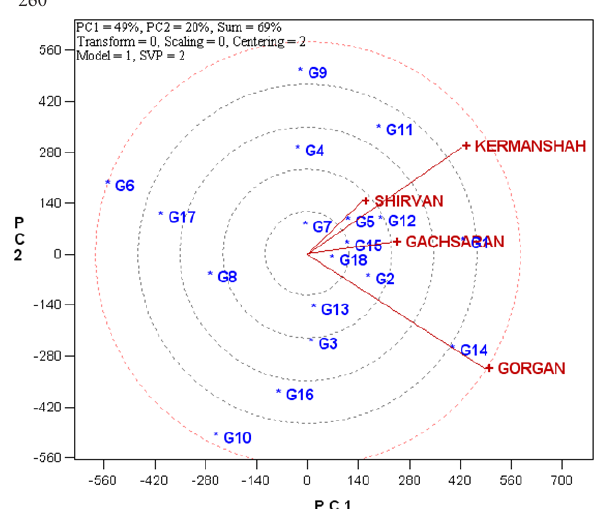
Fig. 3. Vector view of GGE biplot for relationships among loca- tions